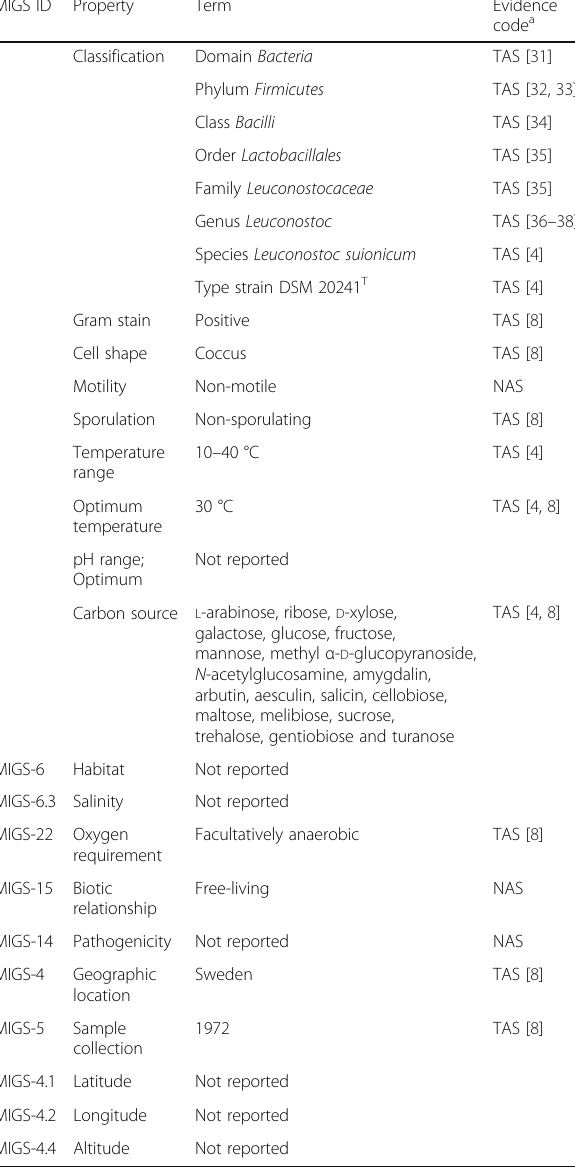
Table 1 Classification and general features of Leuconostoc suionicum DSM 20241 T according to MIGS recommendations